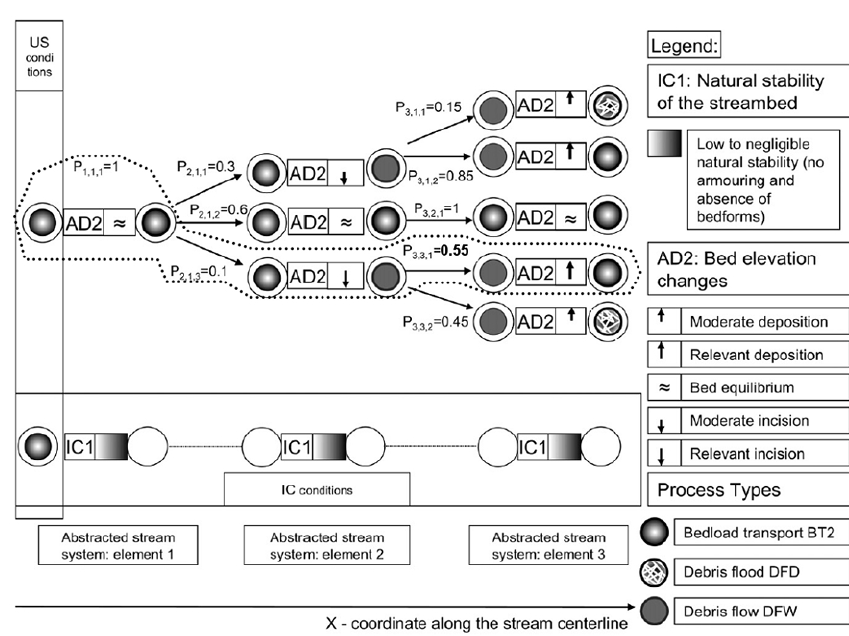
Fig. 2. Fully probabilised process routing scenario tree (modified from Mazzorana et al., 2012).